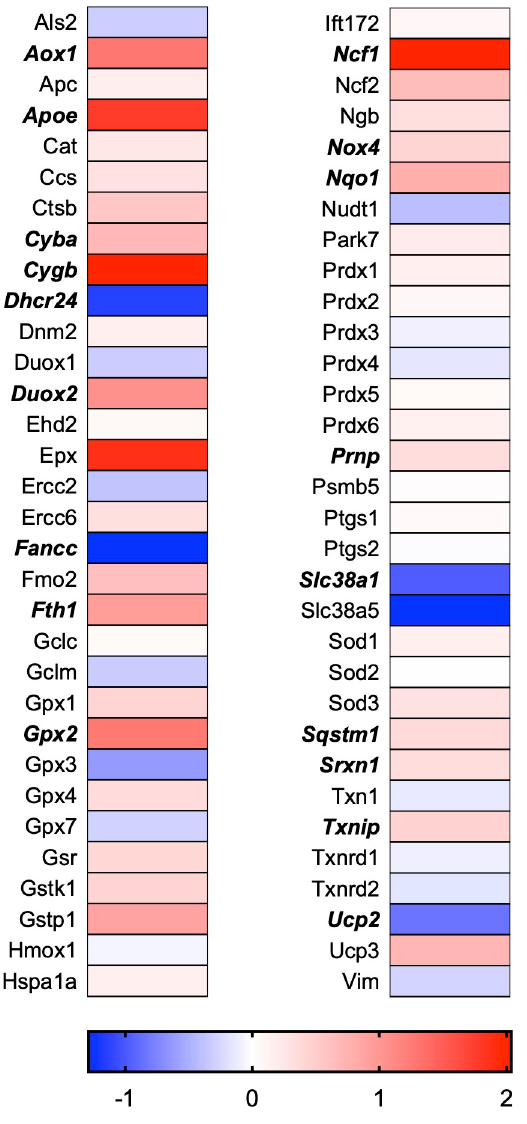
Fig 9. Oxidative stress heat map. Bold text indicates significantly altered gene